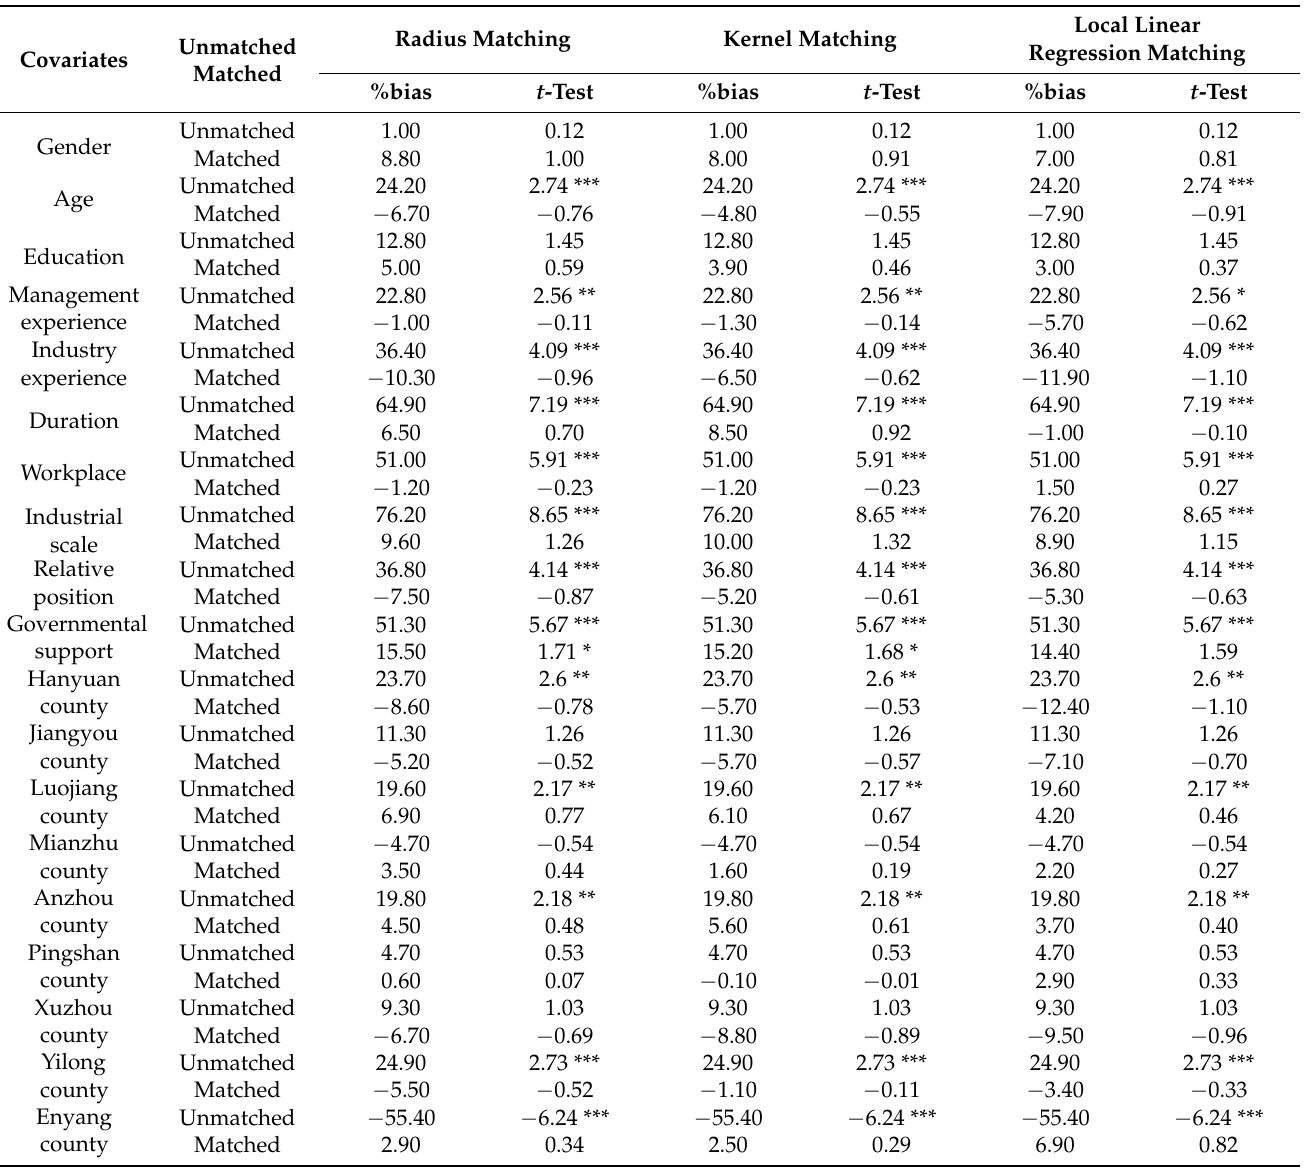
Table 6. Matching balance test